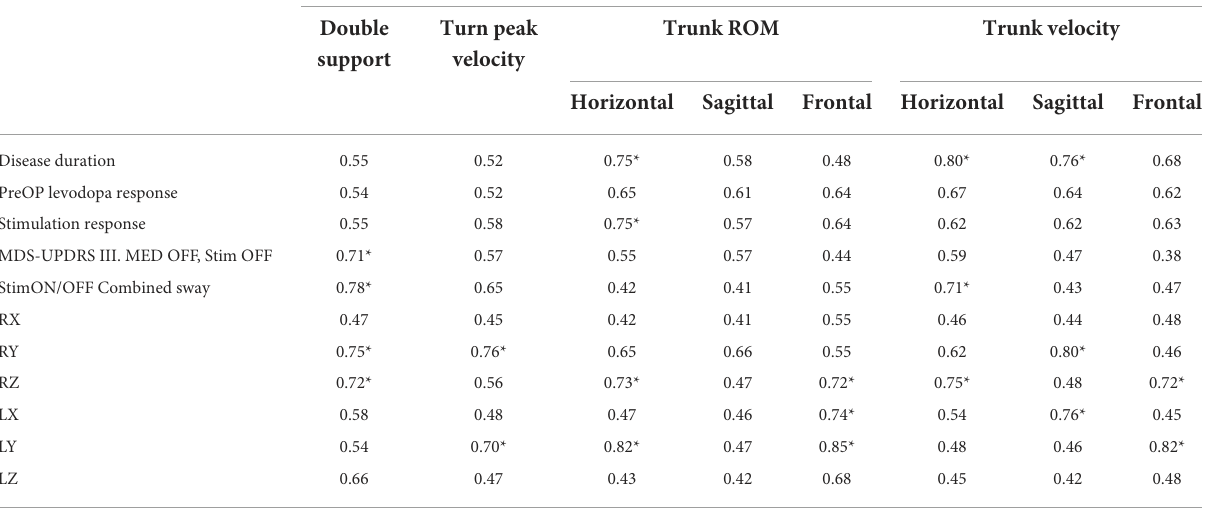
TABLE 3 Coefficients of the support vector regression (SVR)